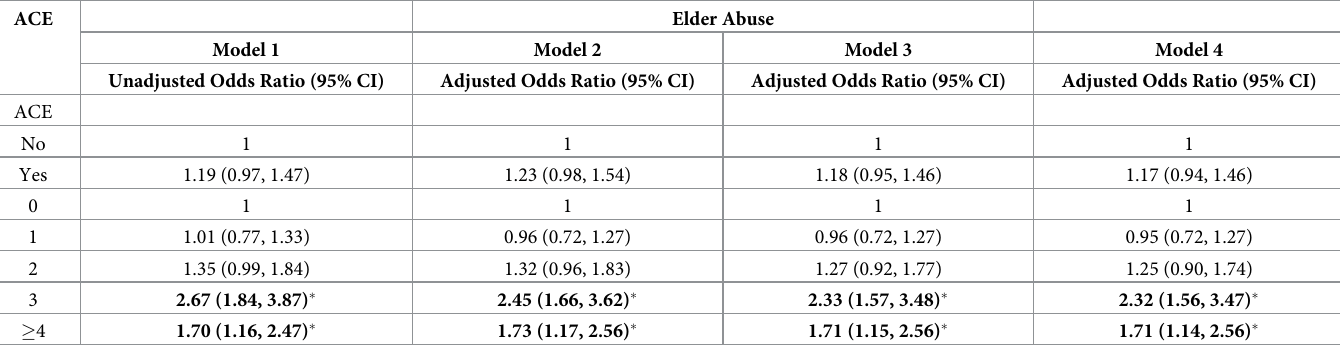
Table 4. Adjusted multivariable relationship between cumulative adverse childhood experiences and elder